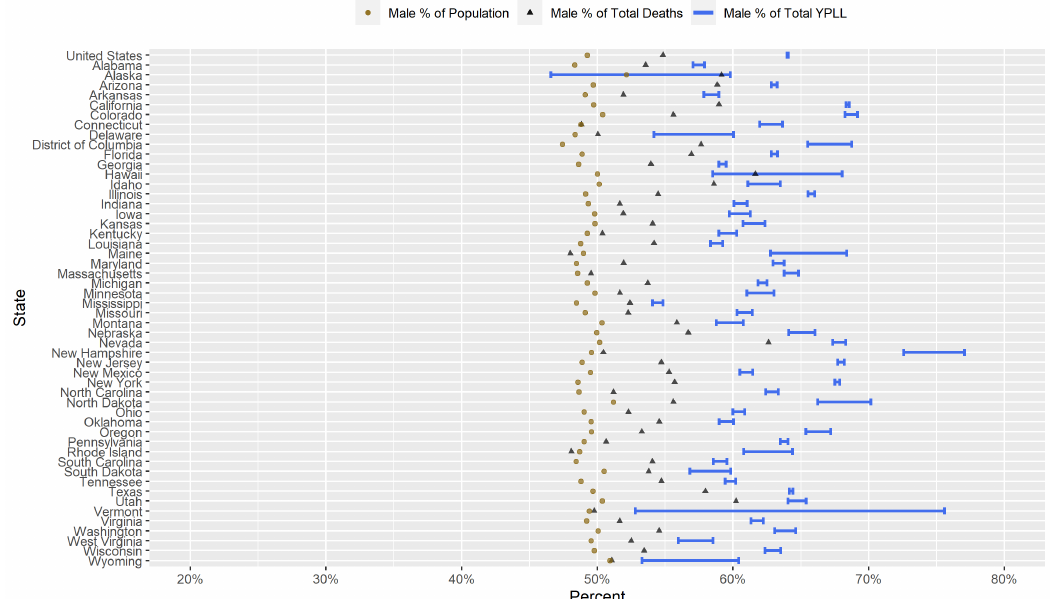
Figure 1. Conservative 95% interval estimates of the percentage of total COVID-19-attributable YPLL before age 75, the percentage of total COVID-19 deaths, and the percent population shares for males in the U.S. and in each of the 50 states and D.C. Quantities calculated with respect to cumulative COVID-19 deaths according to data from the National Center for Health Statistics as of 31 March